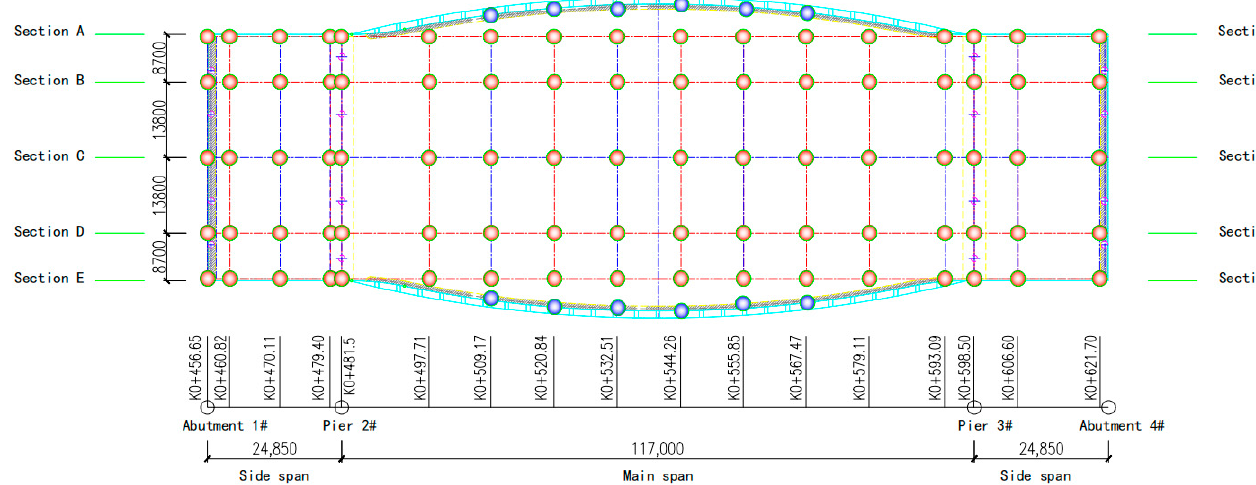
Figure 10. Deformation monitoring points of the bridge deck (unit: mm).